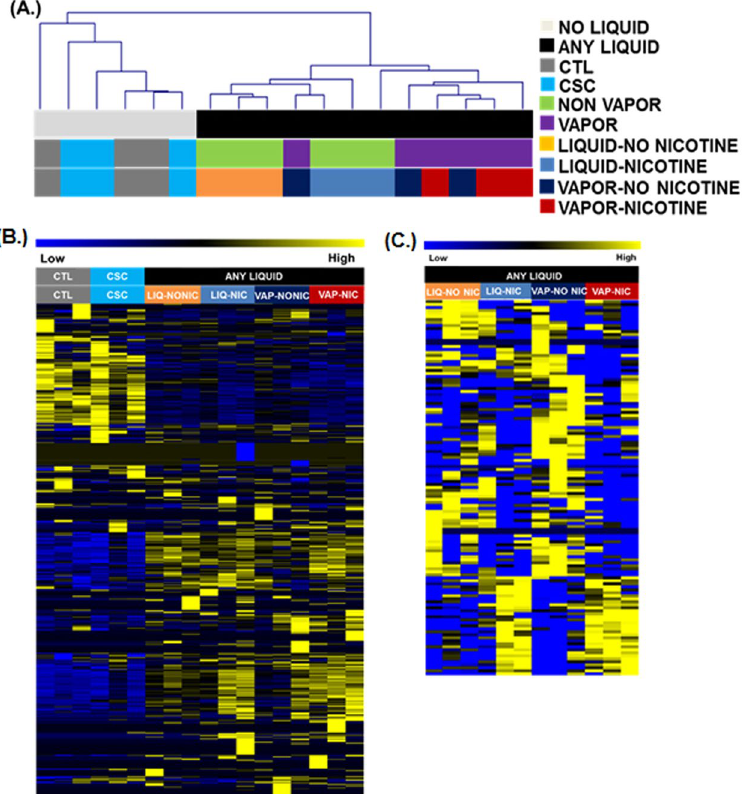
Figure 3. Genome-wide transcriptional analysis of microRNA expression in eCig treated NHBE. ( A ) Treatment with any eCig liquid has a significant effect on miRNA expression. Shown here is a dendrogram representing hierarchical clustering of samples when comparing expression of all 2541 miRNAs. The clusters were generated using Euclidean distance and average linkage clustering. Samples completely segregated based upon treatment with any eCig liquid (black bar). Individual treatment groups were untreated control (CTL), cigarette smoke condensate (CSC), non-vaporized liquid without (LIQ-NONIC) or with (LIQ-NIC) nicotine, and vaporized/condensed liquid without (VAP-NONIC) or with (VAP-NIC) nicotine. ( B ) SAM-Seq identified 578 miRNA significantly differentially expressed between samples with any eCig liquid treatment (n = 12), when compared to controls (n = 3). Shown are normalized expression levels for these 578 selected miRNA. Rows represent miRNA and columns represent samples. Blue indicates low expression, while yellow indicates high expression. ( C ) SAM-Seq identified 125 microRNA as significantly differentially expressed between cells treated with vaporized liquid (n = 6) compared to non-vaporized liquid (n = 6). Shown are normalized expression levels for these 125 selected miRNA. Rows represent miRNA and columns represent samples. Blue indicates low expression, while yellow indicates high